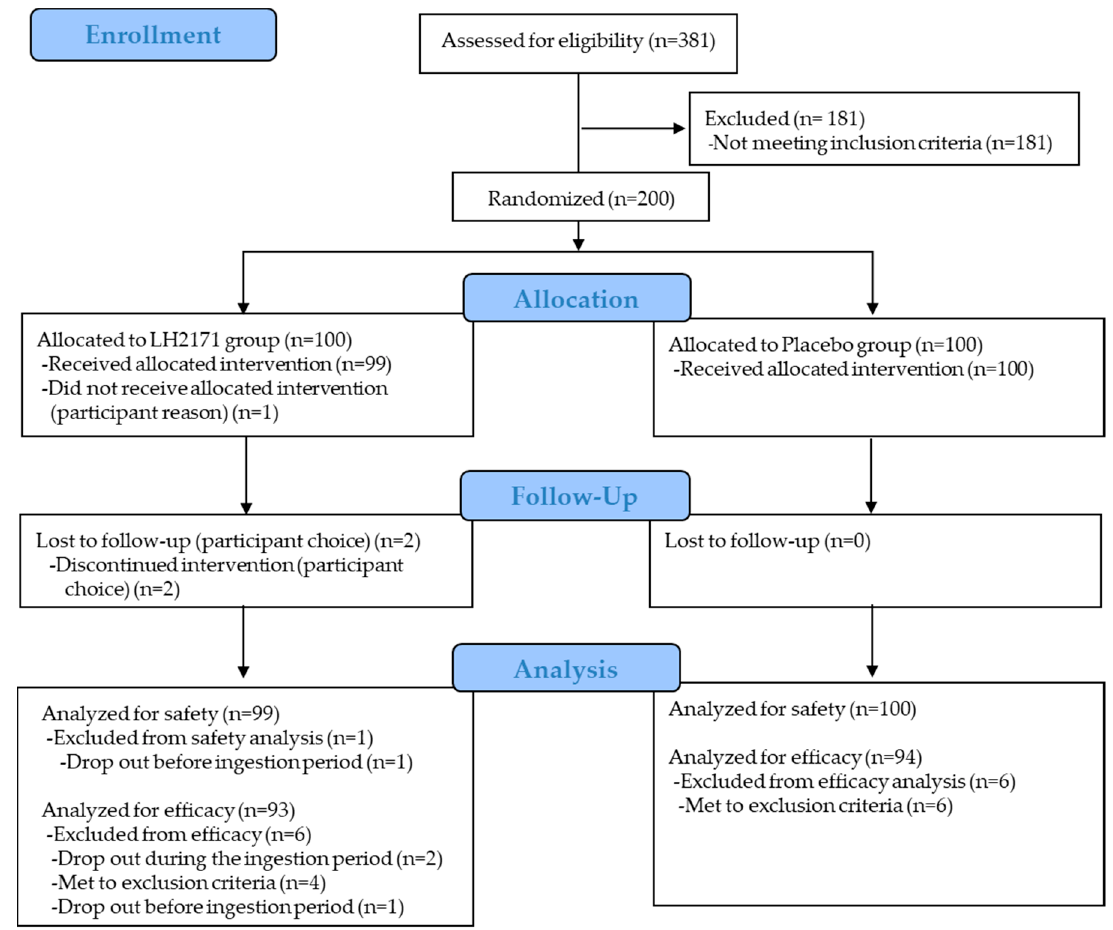
Figure 1. Flow diagram representing the subjects’ disposition. Table 2. Background information on the per-protocol